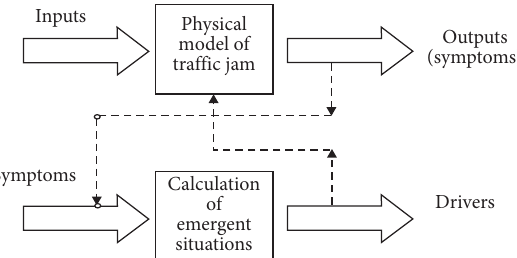
Figure 1: Comparison of the physical model of traffic jam with the block of calculation of emergent